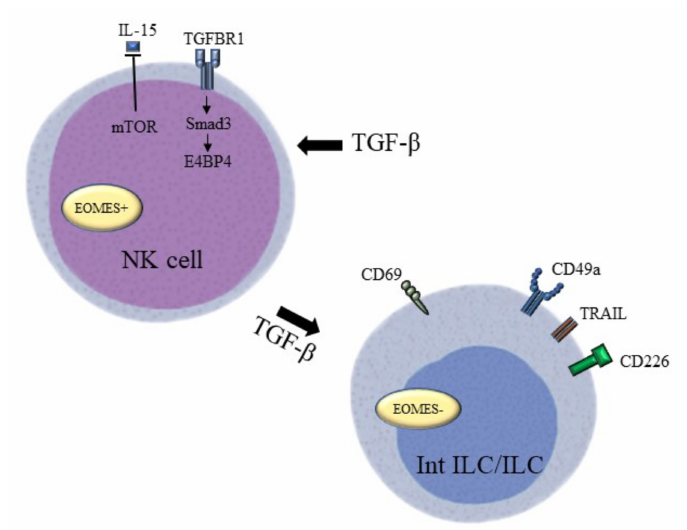
Figure 3. TGF- β targeting factors that “lock” NK cell functions. TGF- β impairs the balance between activatingsignals andinhibitory signalson NKcells toblock theactivation ofNK cells. Theiranti-tumour activity is reduced by downregulating the mTOR pathway and upregulating the Smad3 / E4BP4 pathway. The conversion of NK cell to innate lymphoid cell under the high levels of TGF- β leads to the loss of the metastasis-restraining function of NK cells through the expression of CD69, CD49a, and TRAIL, and the loss of